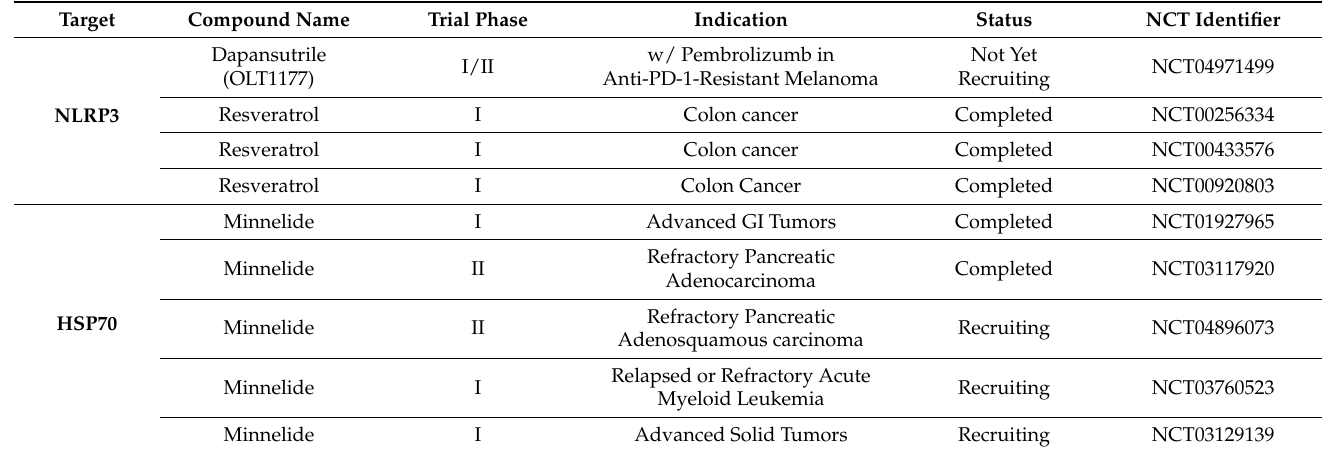
Table 1. Clinical Trial Testing of NLRP3 and HSP70 Inhibitors in